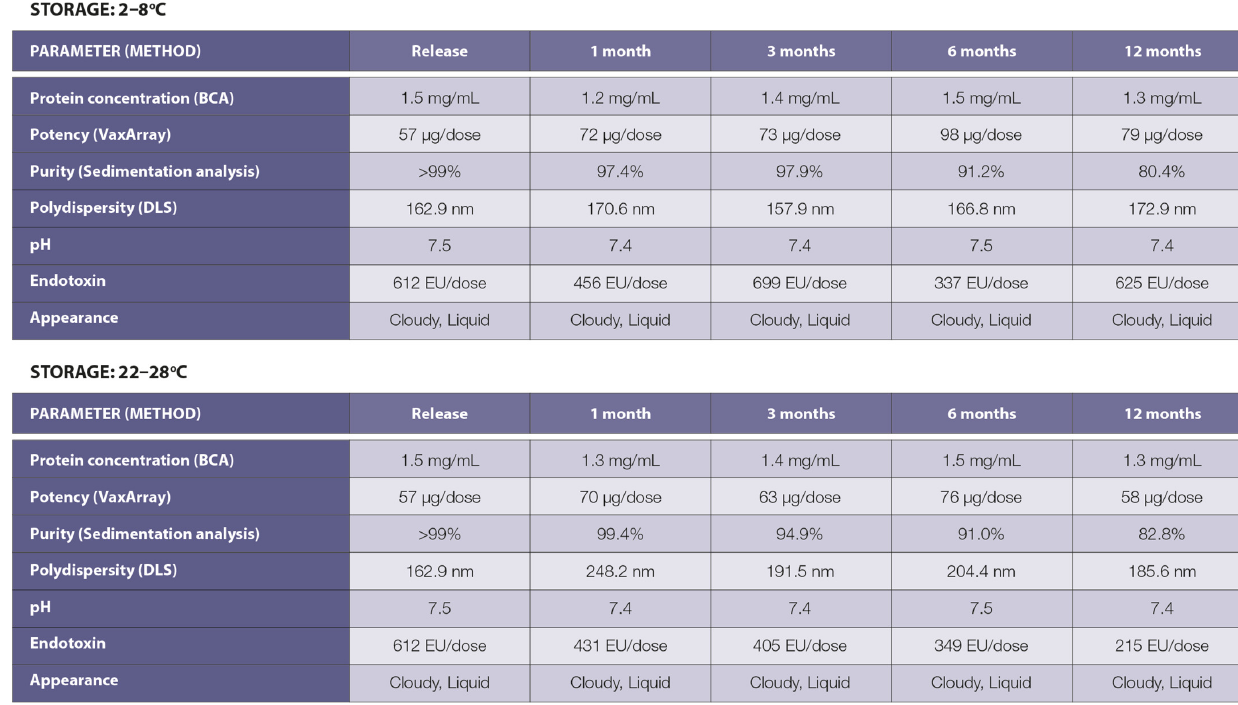
Figure 3. Properties of CoV-RBD121-NP after storage at 2–8 °C or 22–28 °C for up to 12 months. Protein concentration was assessed by bicinchoninic acid assay (BCA), potency by in vitro binding using a custom VaxArray for KBP, purity by AUC calculated from size distribution based on ultracentrifugation analysis, and polydispersity by dynamic light scattering (DLS).